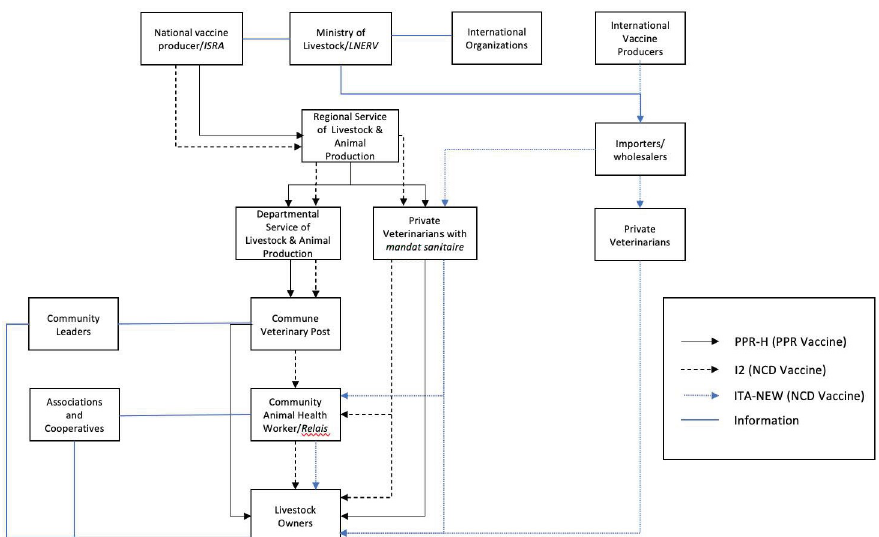
Fig 2. Mapping of PPR and ND vaccine value chains,